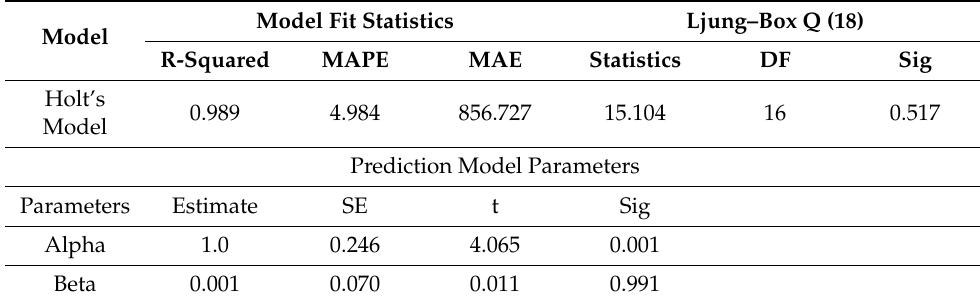
Figure 7. Traffic volume prediction model (forecast and observed values). Table 4. Prediction model parameters and statistics.